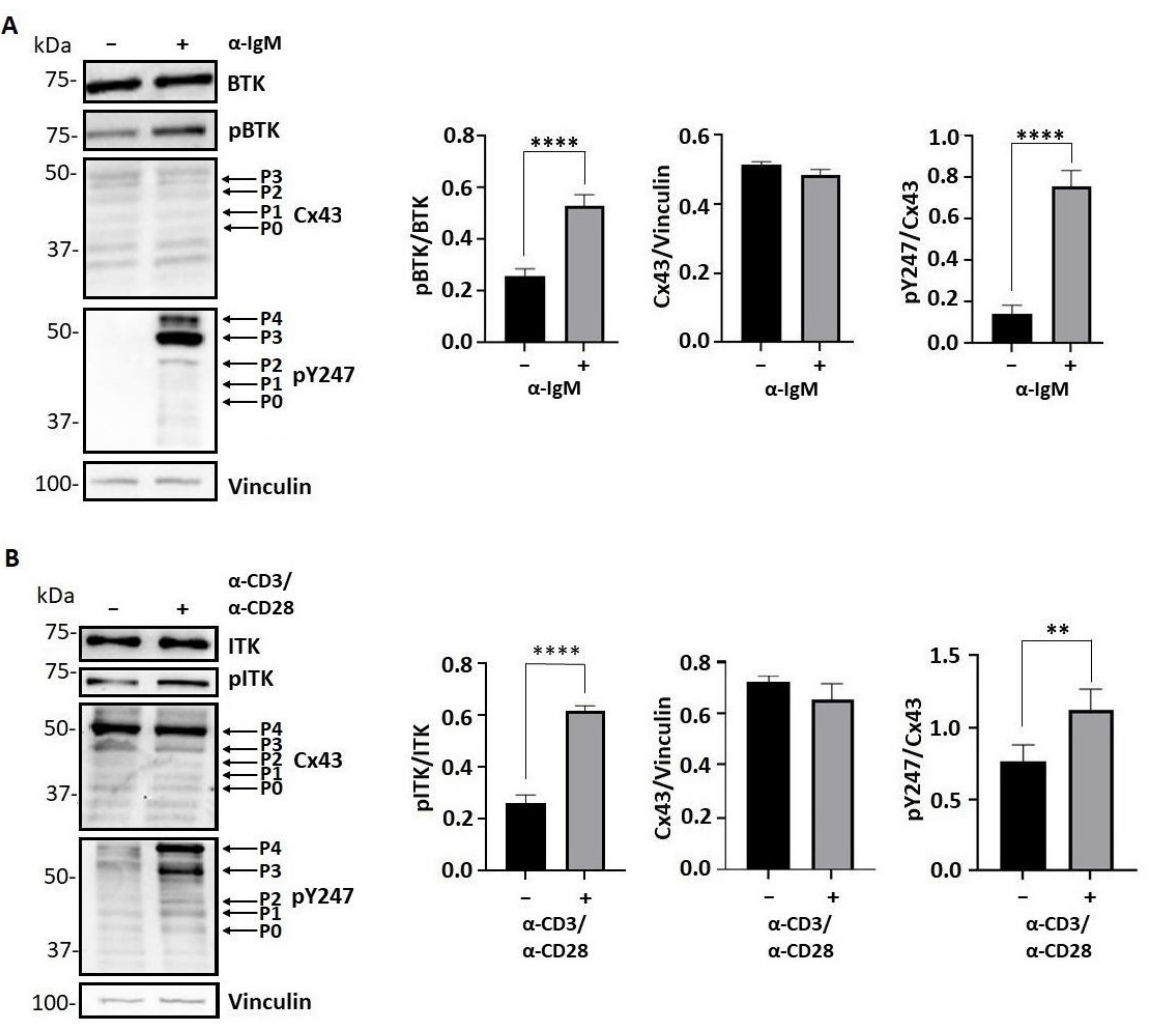
Figure 7. The effect of BTK and ITK phosphorylation on Cx43 regulation in lymphocytes as observed through changes in electrophoretic mobility. Western blot of ( A ) Daudi cells with and without BTK activation using the α-IgM antibody or ( B ) Jurkat cells with and without ITK activation using α- CD3/α-CD28 antibodies. Antibodies used were labeled on the right of each blot. Arrows point to the different migrating Cx43 bands from the electrophoresis. Data were quantified using ImageJ (all units measured in pixels) and GraphPad Prism by Student’s t -test ( n = 3, ** p < 0.01; **** p < 0.0001).